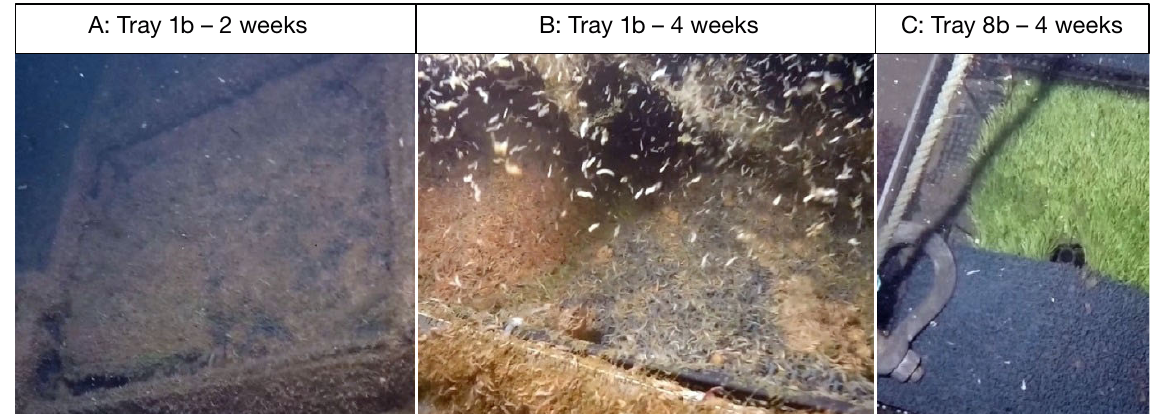
Fig. 1. Inspection by video recordings showing (A) Tray 1b after 2 wk of deployment (70−100% cover), (B) Tray 1b after 4 wk of deployment (70−100% cover) and (C) Tray 8b after 4 wk of deployment (<10%